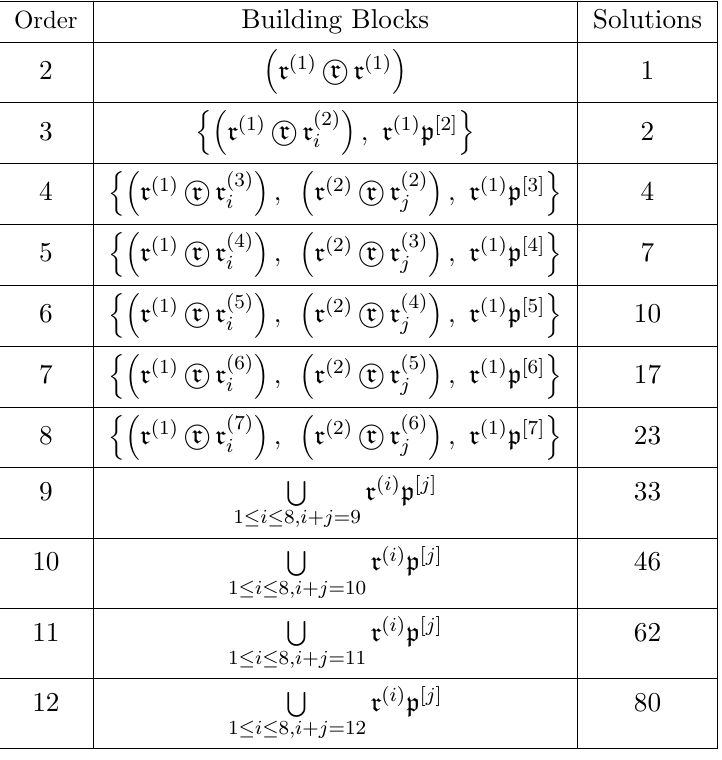
Table 1 . Total number of linearly-independent relaxed numerator scalar solutions at each order in momentum